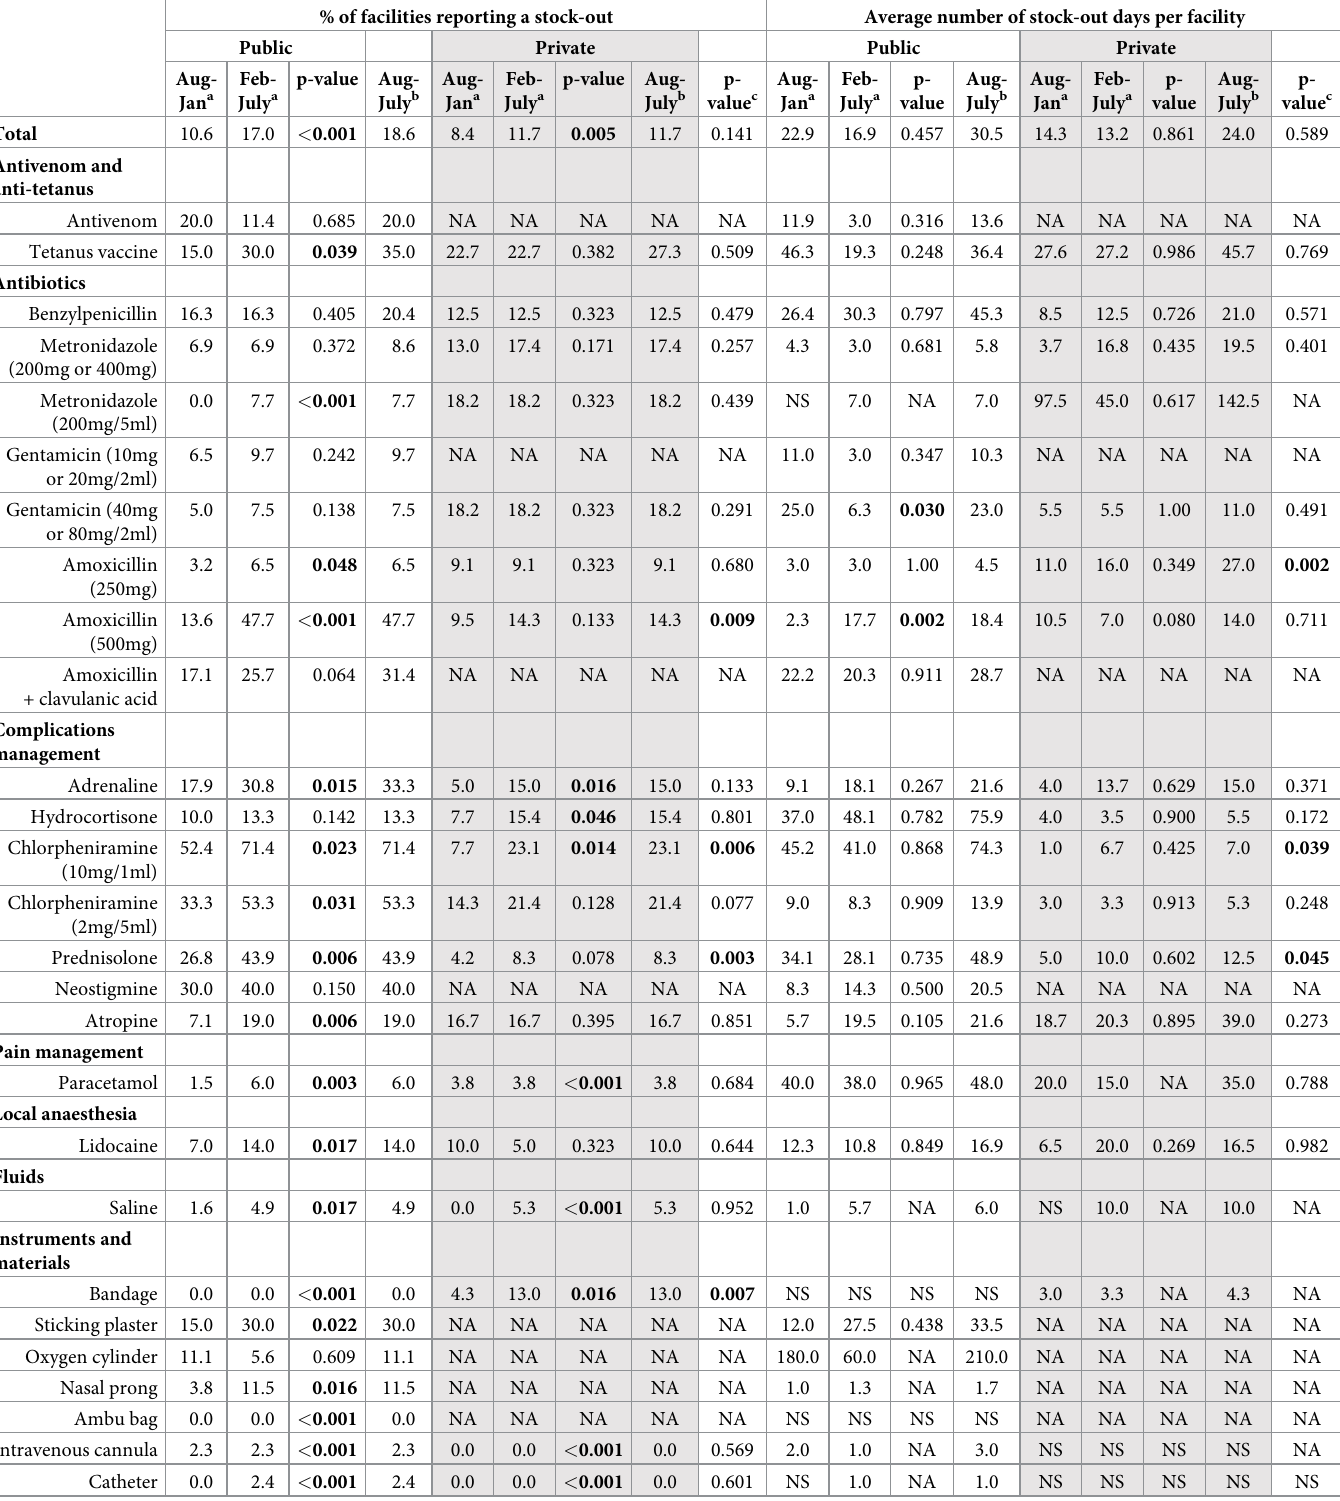
Table 4. Facilities reporting stock-outs of snakebite commodities and average number of stock-out days per facility over a six- and twelve-month period, per